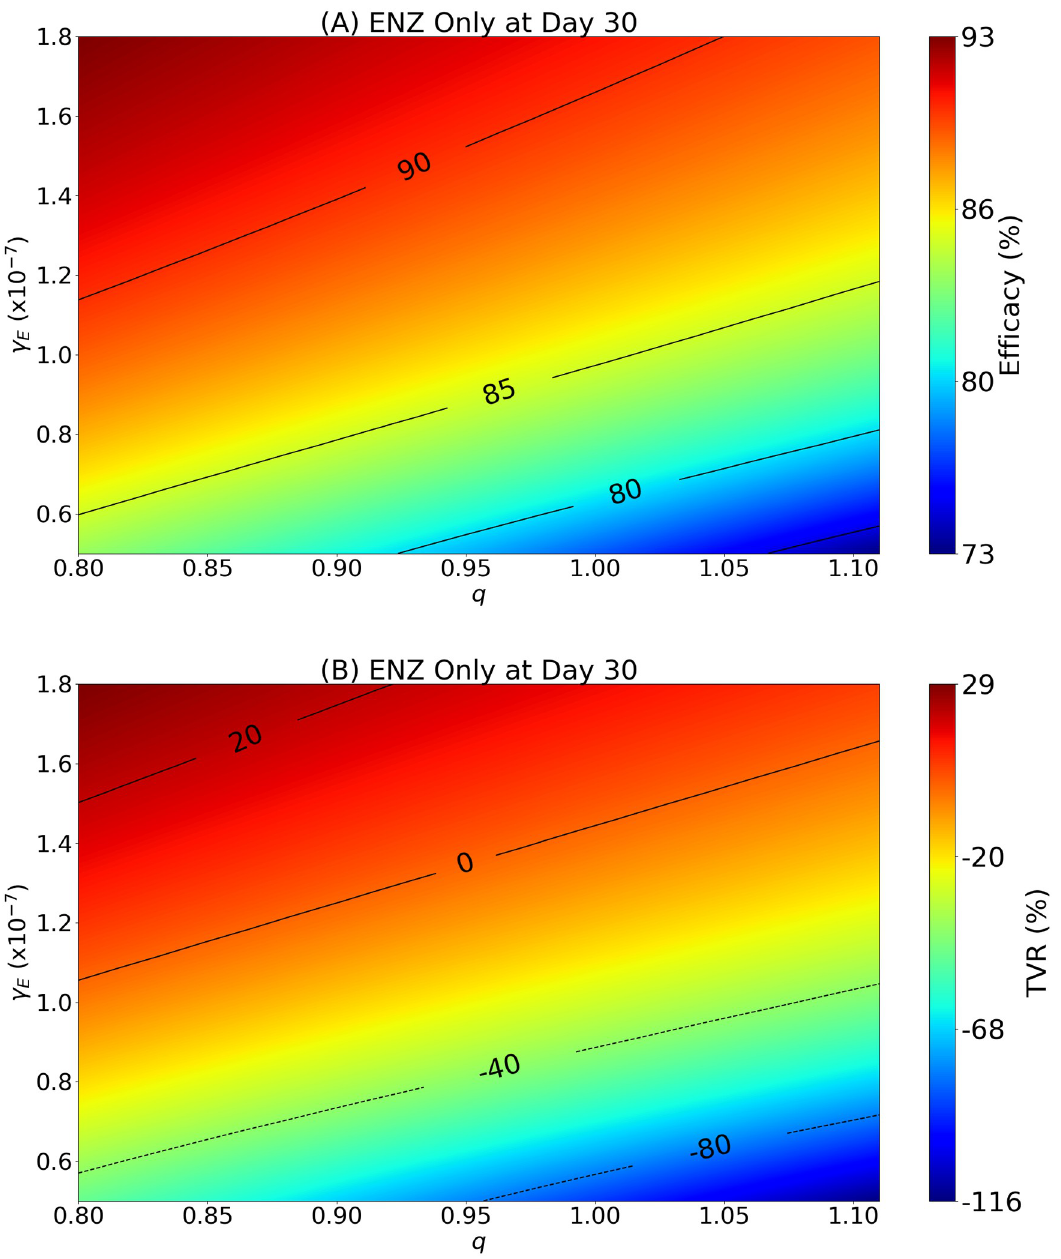
Fig 5. Benefit maps for treatment with ADT. To each value of the personalized parameter q and ENZ dose amount γ column in (A) indicates the efficacy, and in (B) indicates the TVR: 0.8 < q < 1.11 and γ E varies in the range 0.5–1.8 × 10 − 7 g/cm 3 � d. In Fig 4: q = 0.8, γ = 10 − 7 g/cm 3 � E